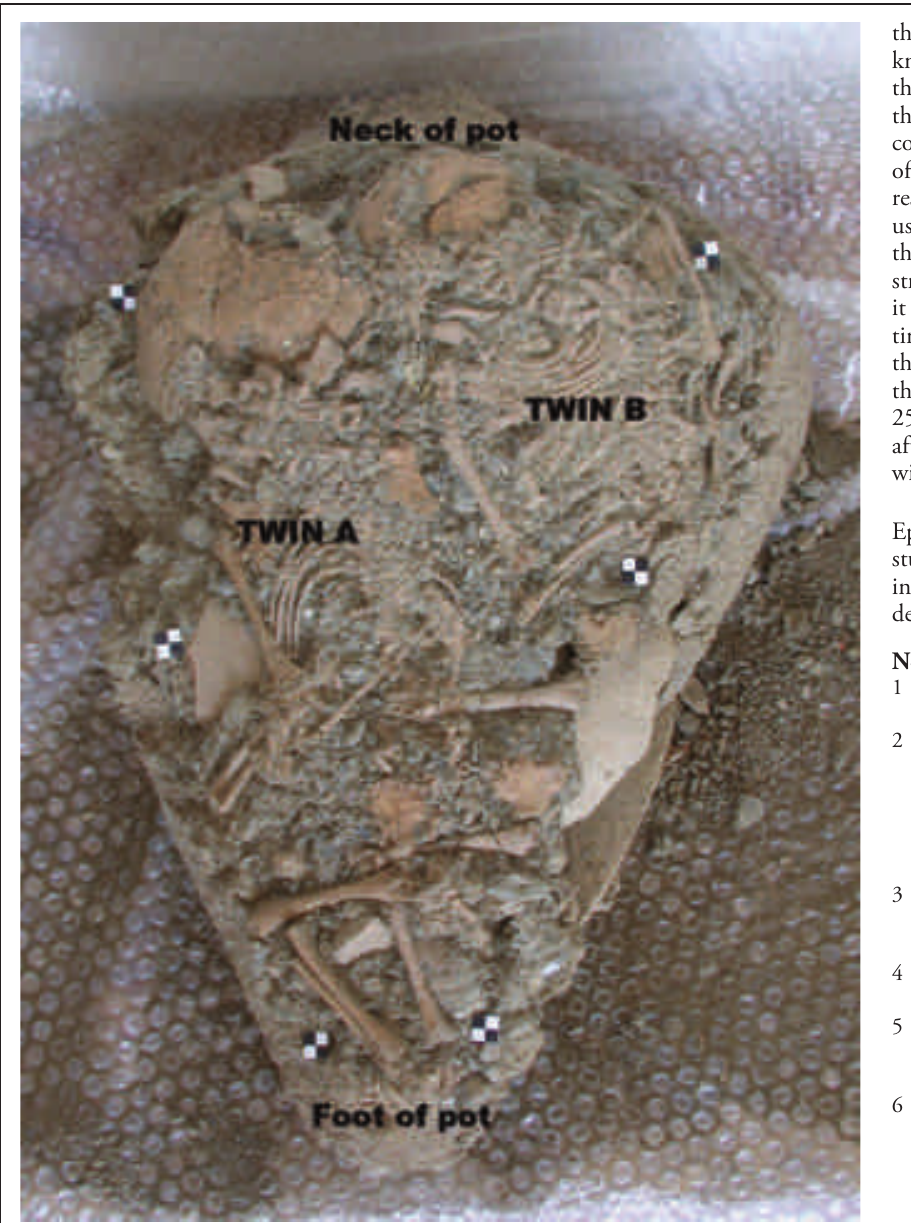
Figure 11 Two neonate skeletons buried within the same